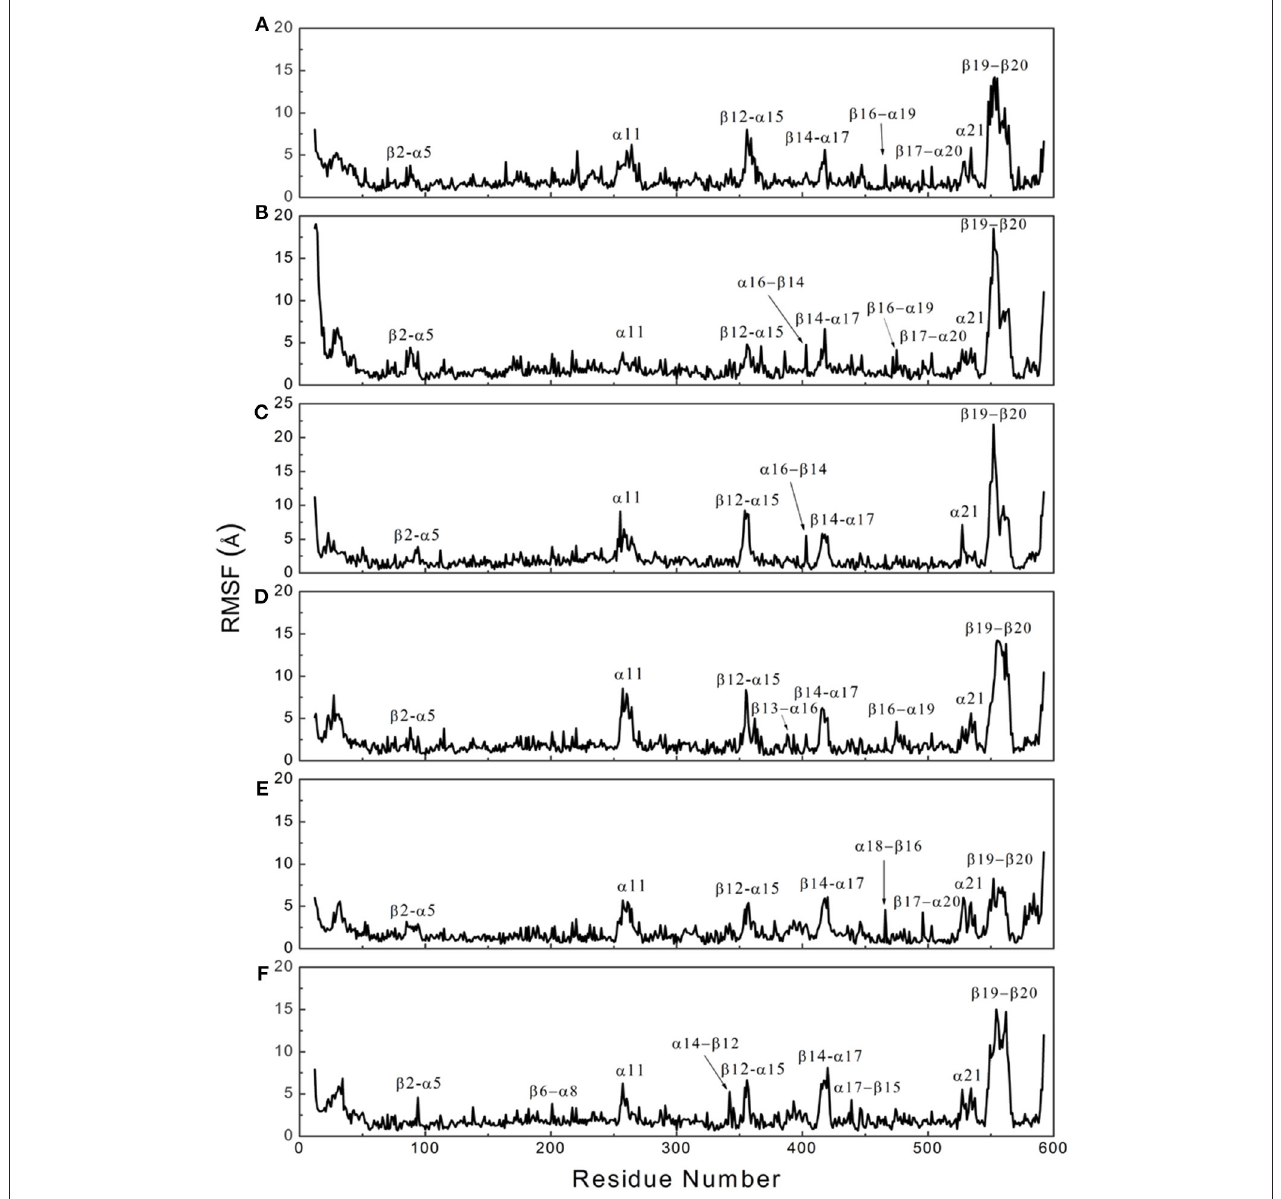
FIGURE 5 | RMSF plots of C α atoms of COI1 in the six systems. (A) system 1, COI1 + ASK1; (B) system 2, COI1 + ASK1 + 1,5-InsP 8 ; (C) system 3, COI1 + ASK1 + 1,5-InsP 8 + JA-Ile; (D) system 4, COI1 + ASK1 + JAZ1 + JA-Ile; (E) system 5, COI1 + ASK1 + JAZ1 + 1,5-InsP 8 ; (F) system 6, COI1 + ASK1 + JAZ1 + 1,5-InsP 8 + JA-Ile.